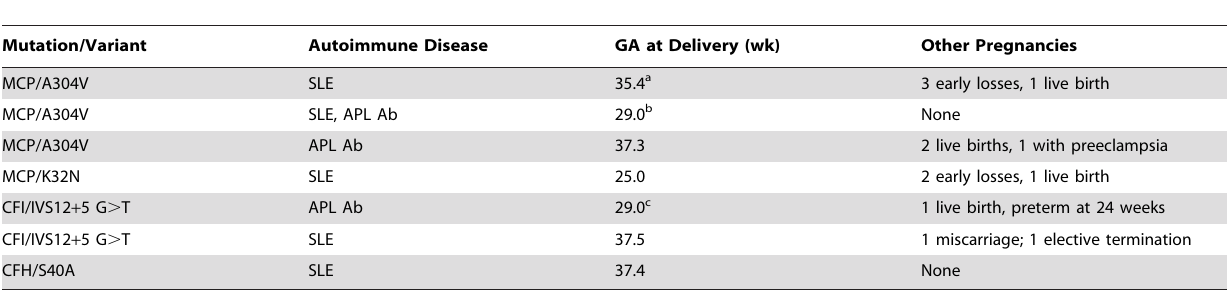
Table 2. Clinical characteristics of autoimmune patients with complement regulatory protein mutations.